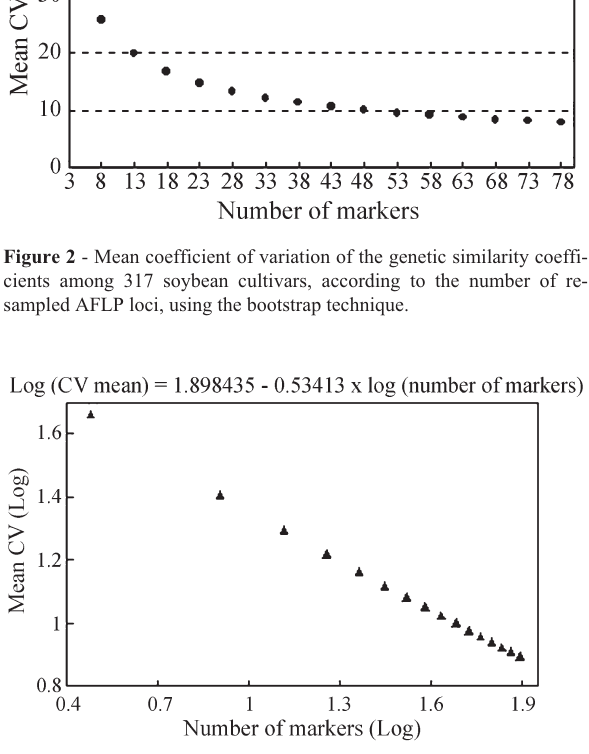
Figure 3 - Regression equation between the natural logarithm of the num- ber of re-sampled AFLP loci and the natural logarithm of the mean coeffi- cient of genetic similarity coefficients using the bootstrap technique.